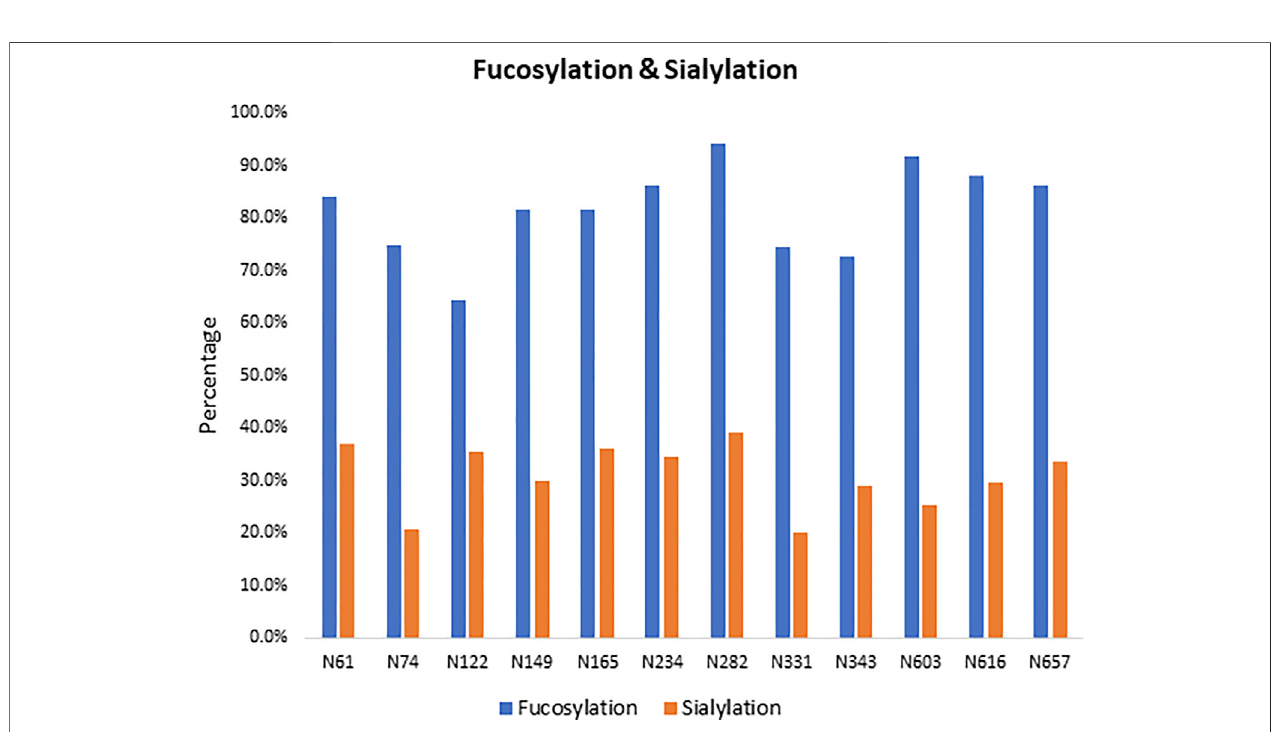
FIGURE2| FucosylatedandsialylatedN-linkedglycosylationoftherecombinantS1protein.Twelveof13potentialN-glycosylationsiteswerefoundoccupied,and these N-linked glycans are highly fucosylated.